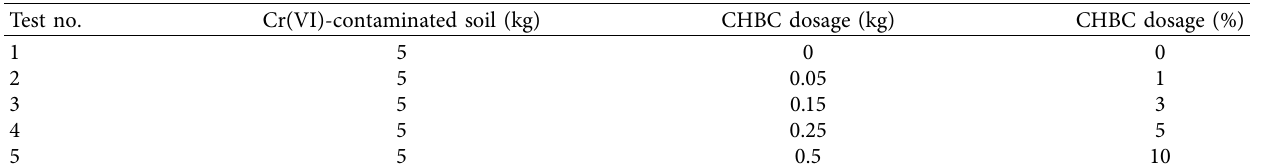
Table 3: Experimental design for the stability